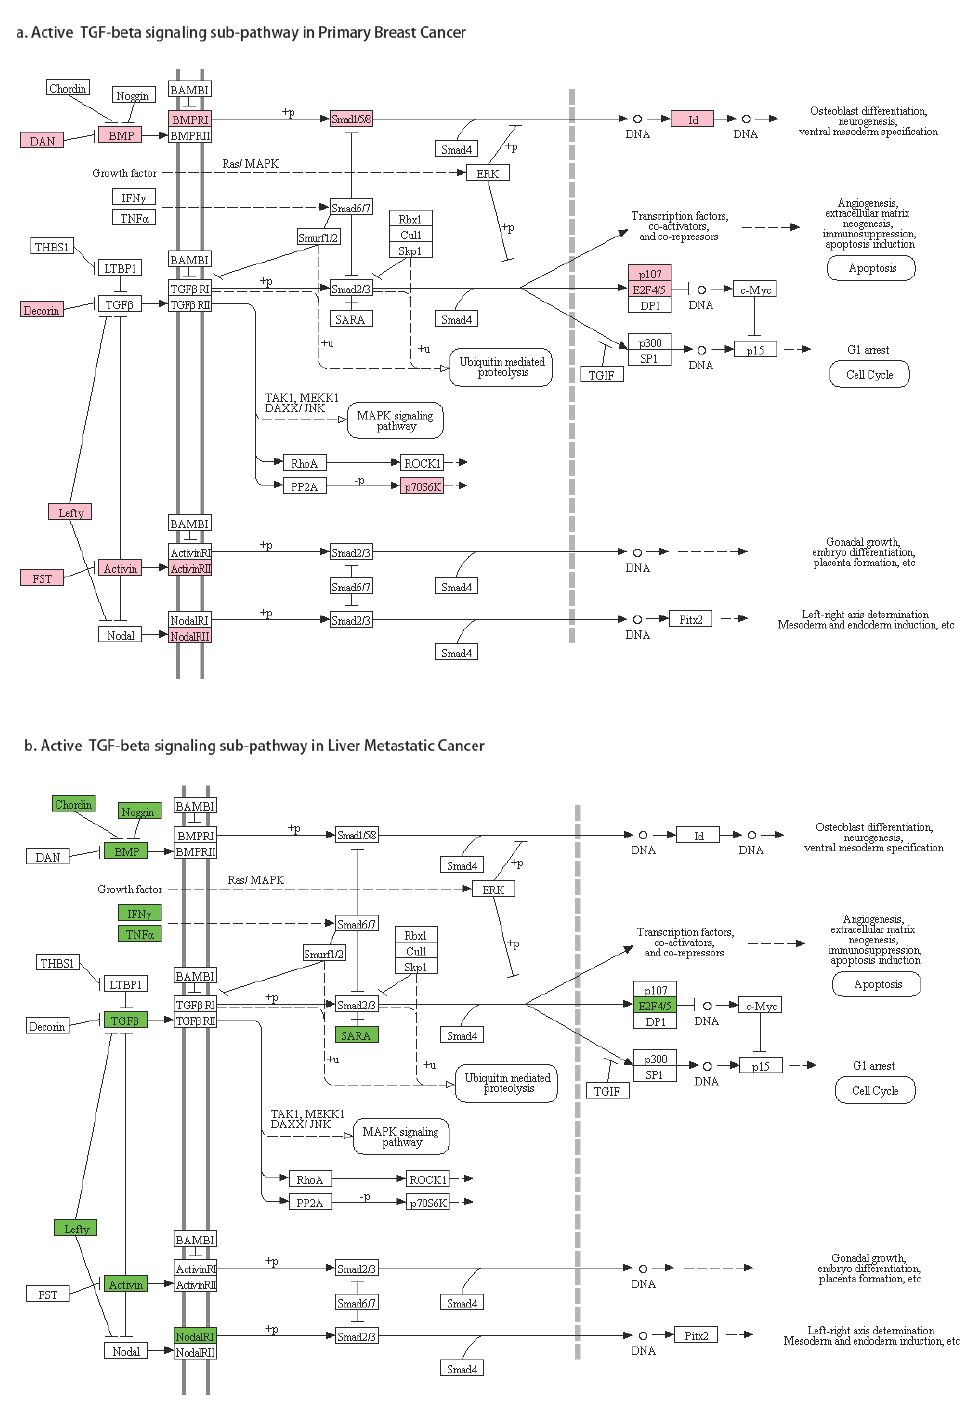
Figure 7. Gene activities in the TGF beta signaling pathway.